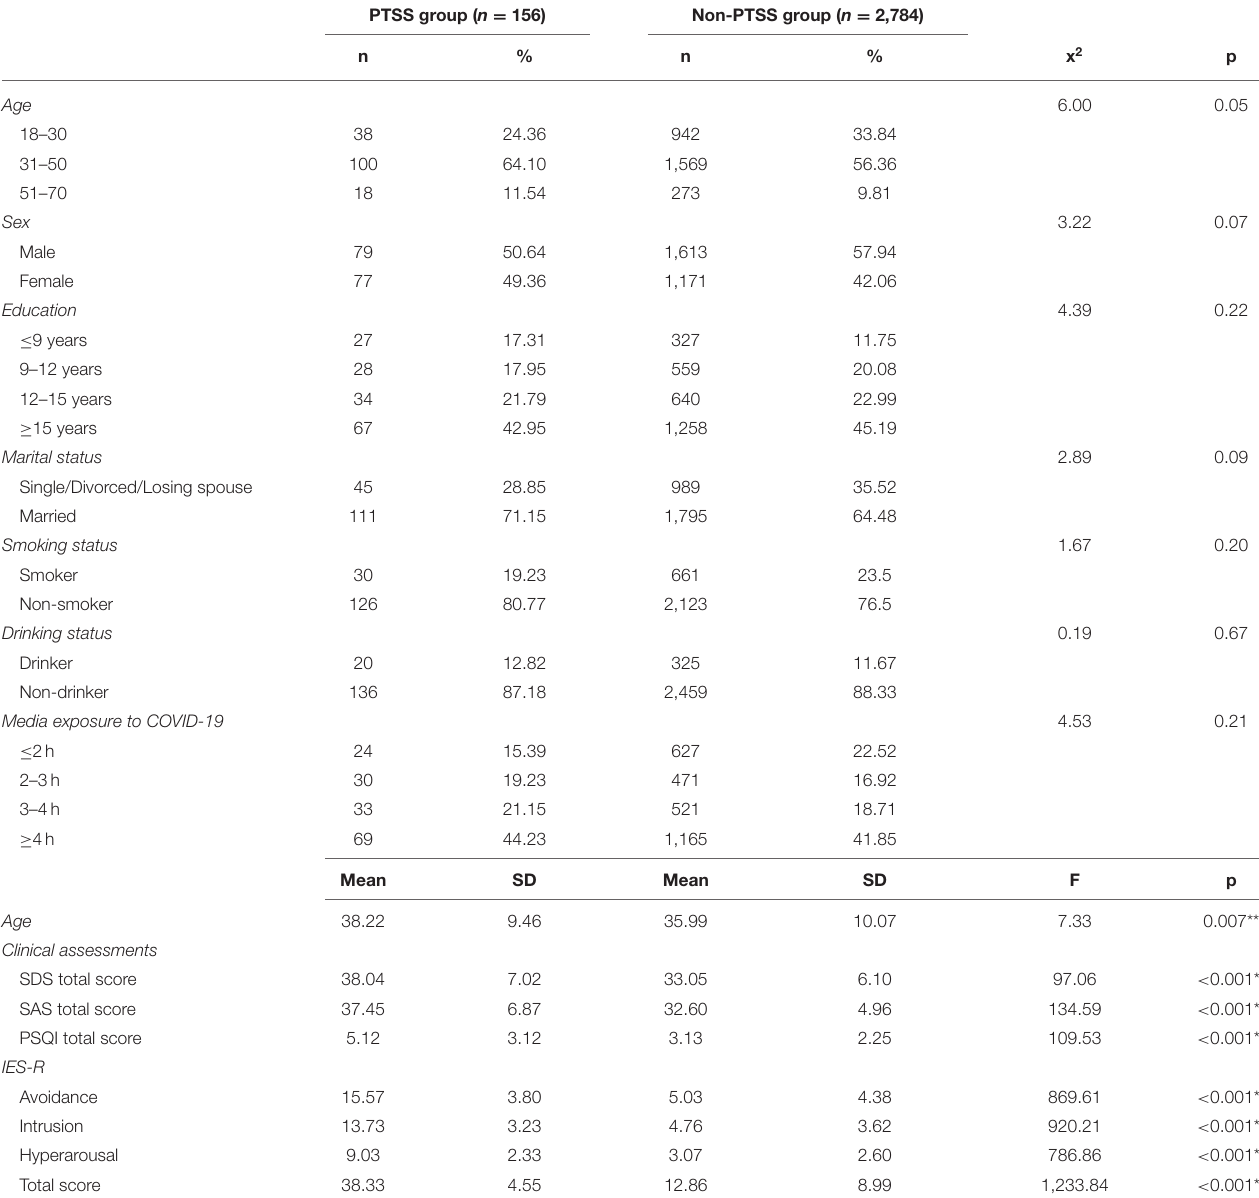
TABLE 5 | Social demography and clinical characteristics of non-depressed subjects with PTSS and without-PTSS (IES-R ≥ 33) (x 2 and